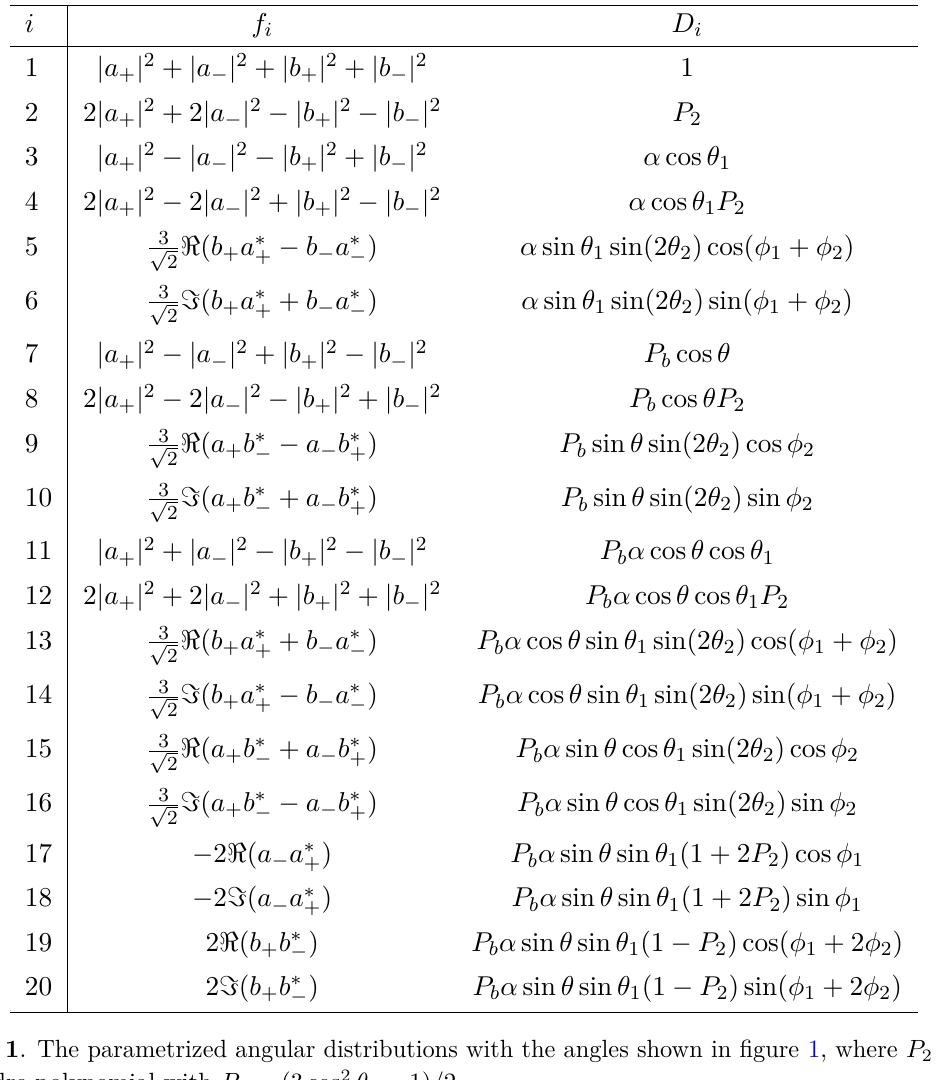
= (3 cos 2 θ 1) / 2 2 2 −